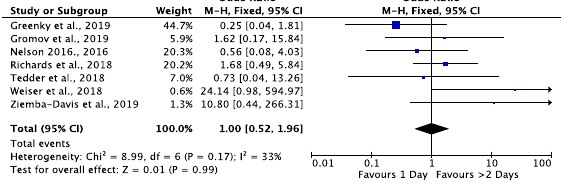
Forest plot of the outcome: infections